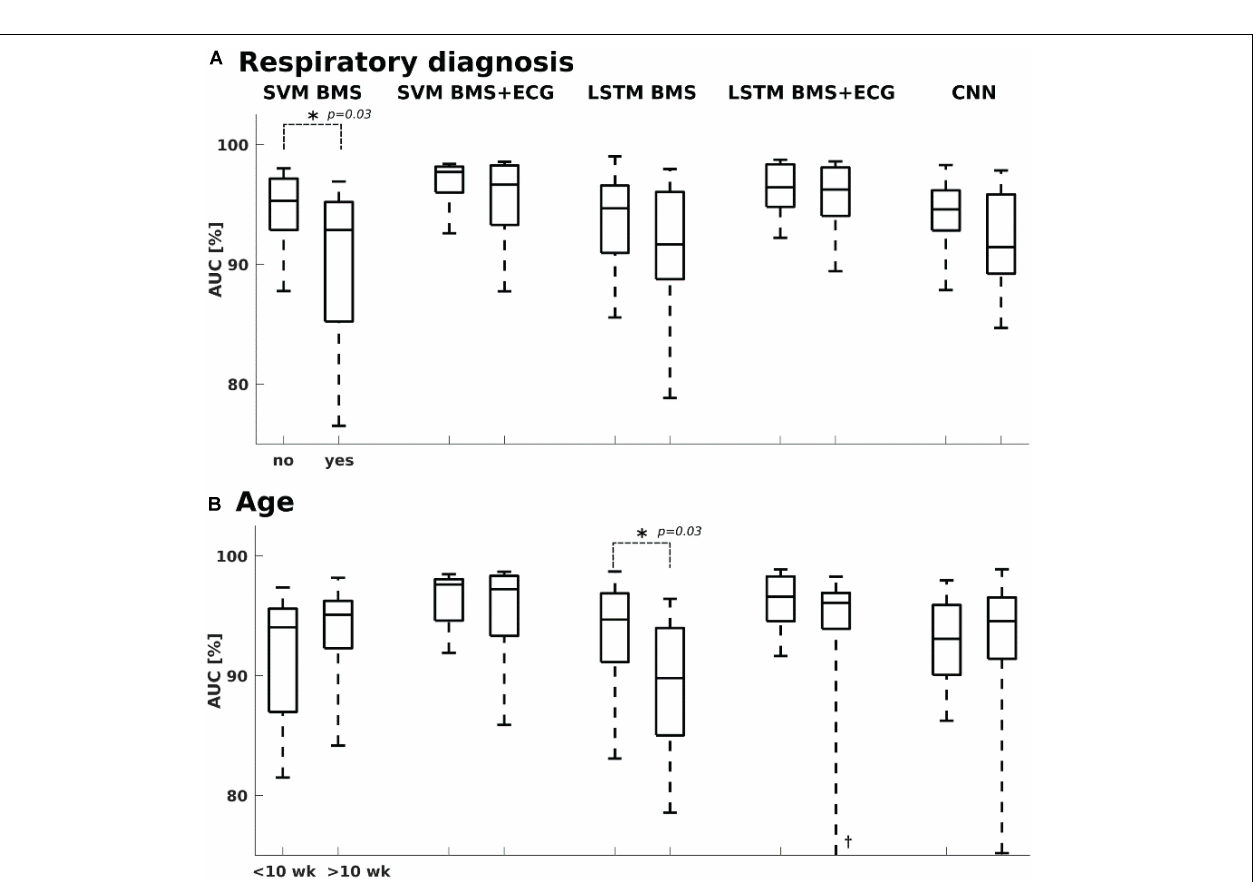
FIGURE 4 | Classifier performance vs. clinical context. (A) SVM BMS classifier showed slightly higher performance with infants who did not have a diagnosis related to respiratory issues, while no significant difference was seen with other classifiers. (B) Only the performance of LSTM BMS was slightly lower with the older age group ( > 10 weeks). † Lower whisker at 58%. The age refers to postnatal age, or age after term equivalent age.